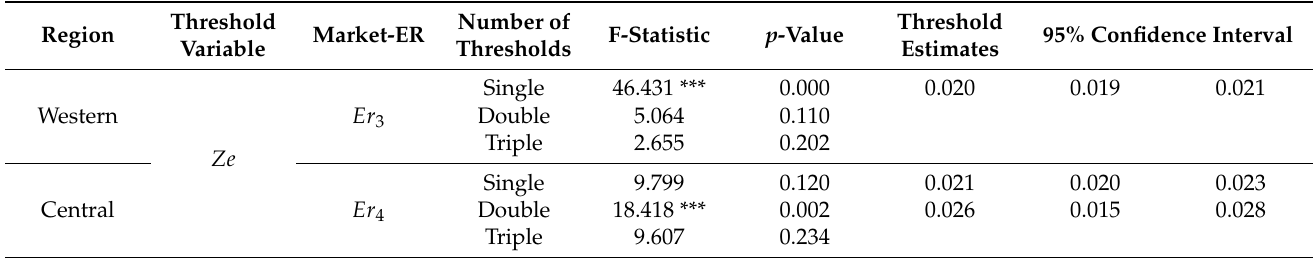
Table 11. Threshold effect test: the central and western